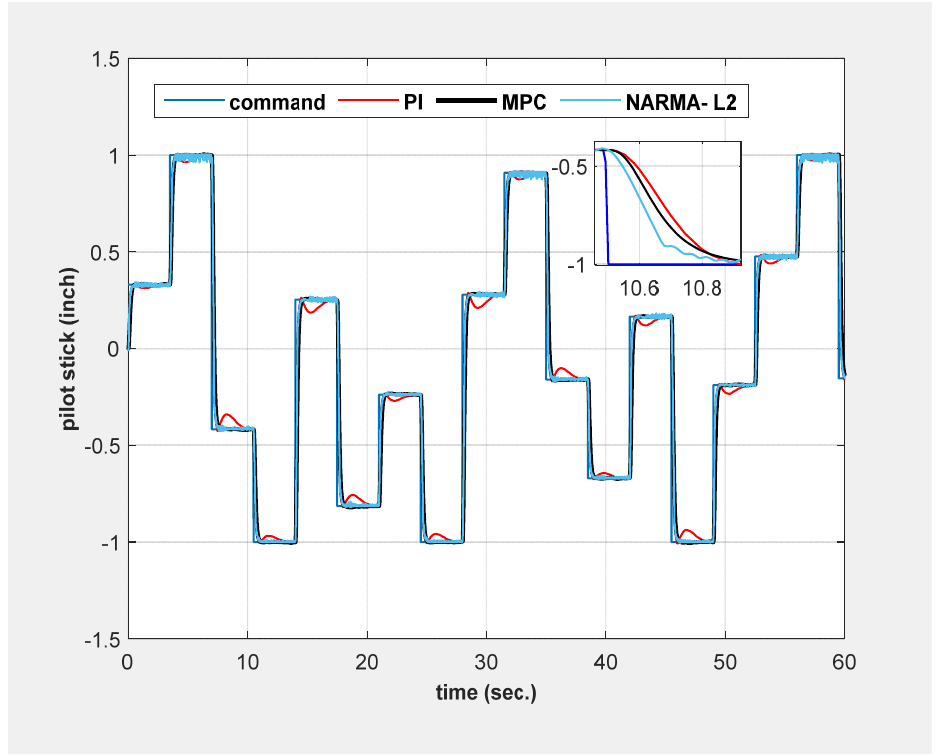
Figure 15. Pilot stick multistep response without corresponding error.